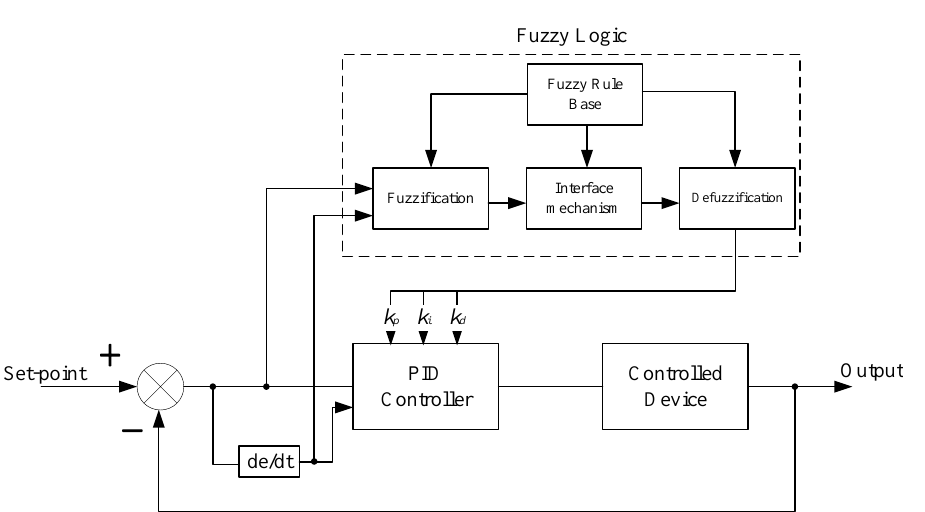
Figure 8. Structure of fuzzy logic based PID